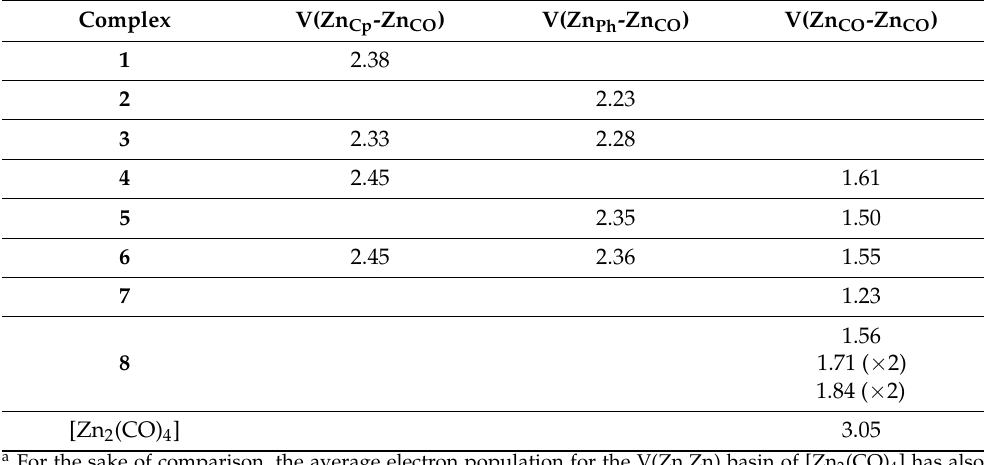
Table 6. Average electron population in polysynaptic metal basins a